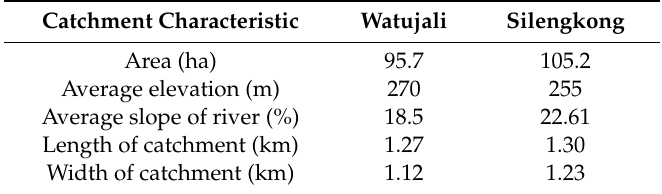
Table 1. Physical characteristics of Watujali and Silengkong